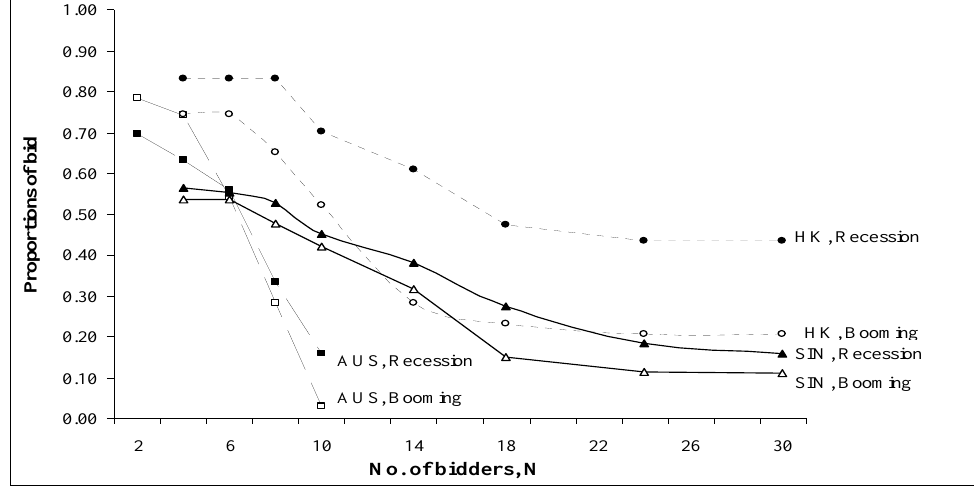
Figure 1: Sample proportions of 'bid' responses according to country / territory, market conditions and number of